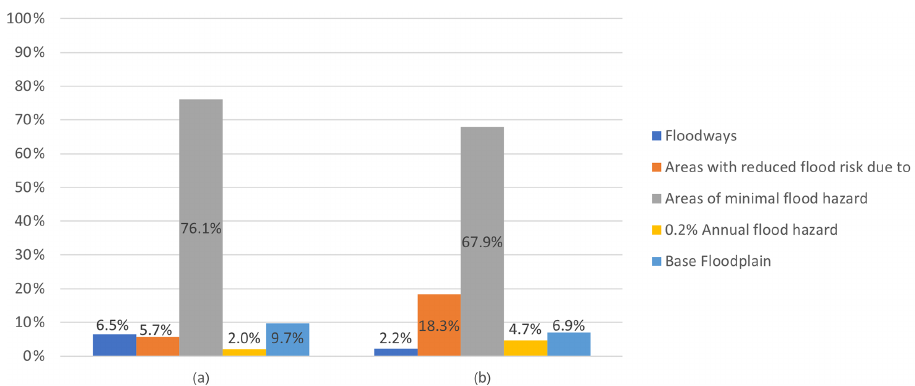
Figure 6. (a) Distribution of NFHL flood zone areas across the study region, (b) flood alerts in NFHL flood